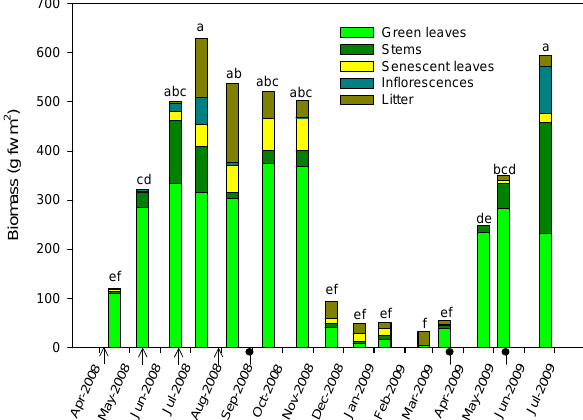
Fig. 2. Seasonal variation in biomass of fresh matter of different tissues of ryegrass. Arrows represent N application as NH 4 NO 3 ; the bar with solid circle represents N application as urea. Values are means of 4 replicates (2 in each of the North and South fields). Different letters indicate significant differences at P < 0.05.